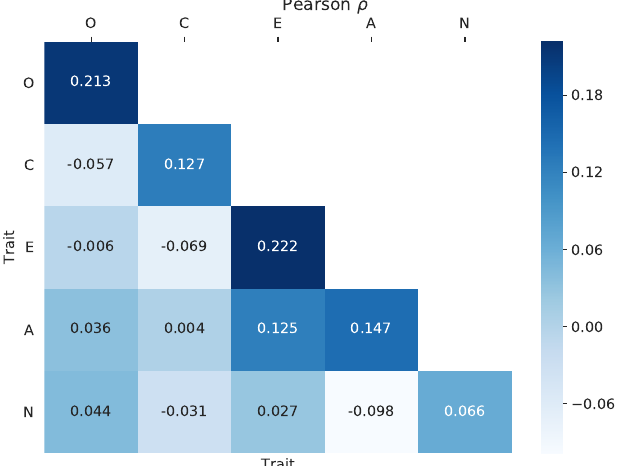
Figure 4. Pearson correlation coefficient ( ρ ) between the image choice and the personality score in the questionnaires. Knowing the test score for a personality trait allows prediction of the image choice for the chosen personality trait. Thus, our model is able to successfully predict images that a person with a given level of a trait will